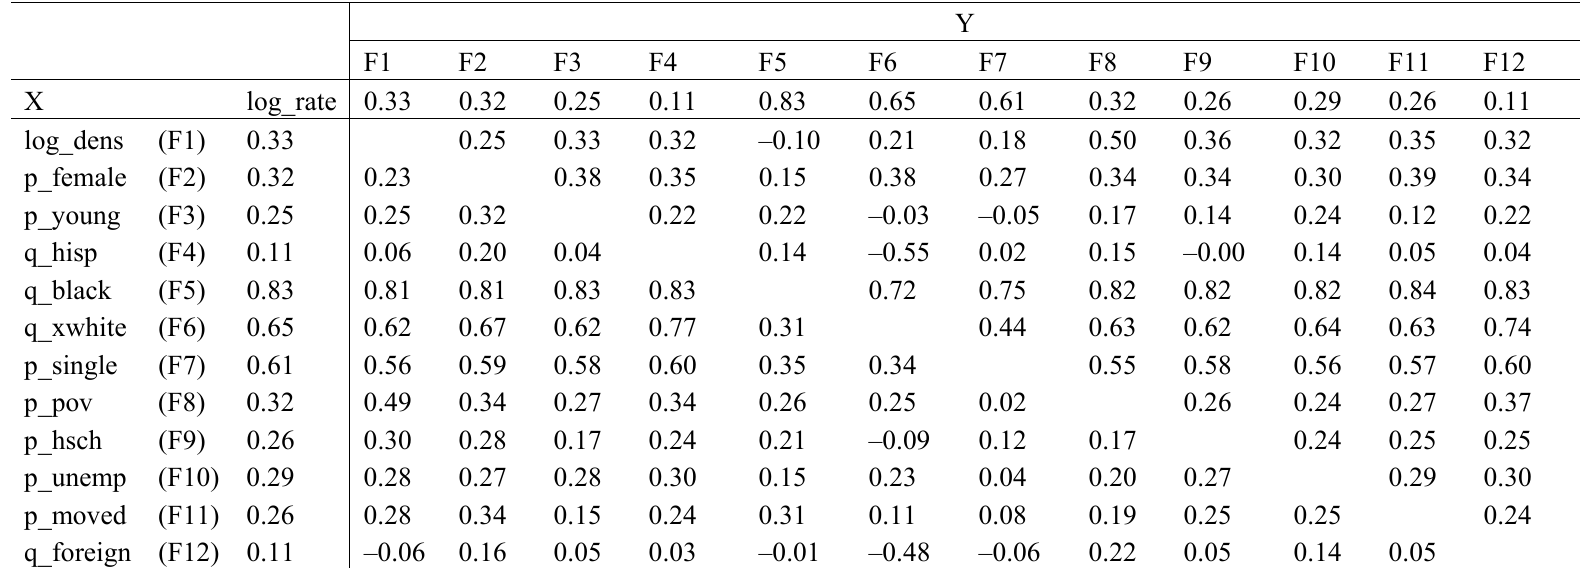
Table 1. Correlations between the gonorrhea diagnosis rate and both SDH variables and demographic variables, and partial correlations between variable X and gonorrhea diagnosis rate adjusted with variable Y, based on data at the CPOA level: National Notifiable STD Surveillance and American Community Survey data,